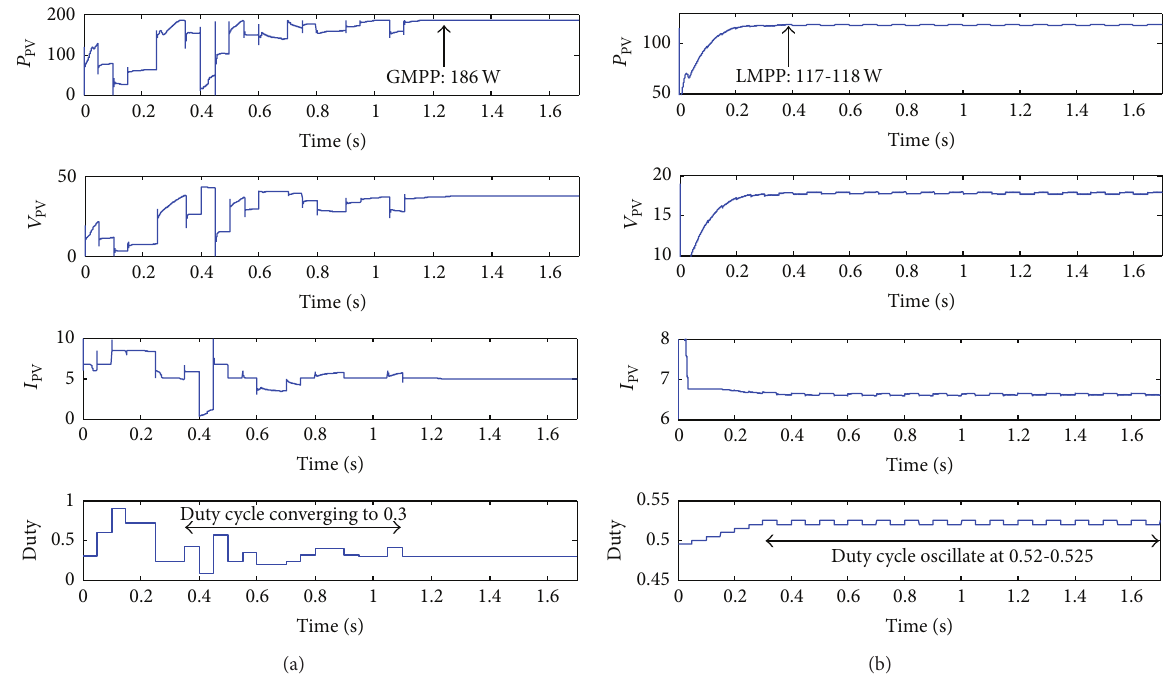
Figure 6: Simulation results for PV array under partial shading of 1.0kW/m 2 , 0.8 kW/m 2 , 0.7 kW/m 2 , and 0.6 kW/m 2 ; (a) proposed DE algorithm and (b) P&O algorithm.